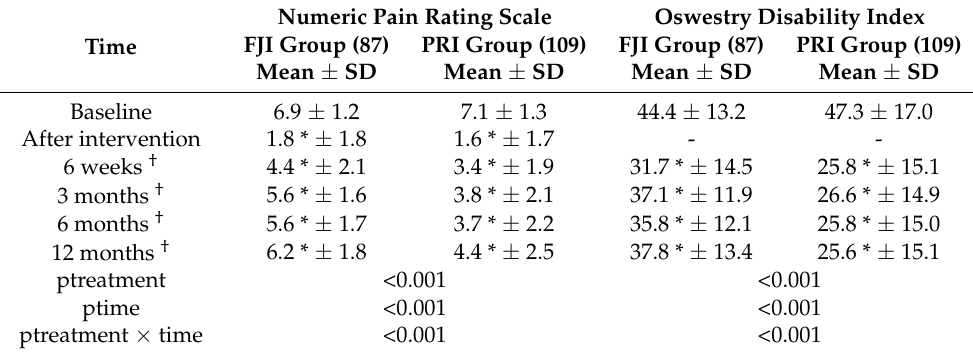
Table 2. Comparison of Numeric Pain Rating Scale (overall) and Oswestry Disability Index score between groups FJI and PRI over time.